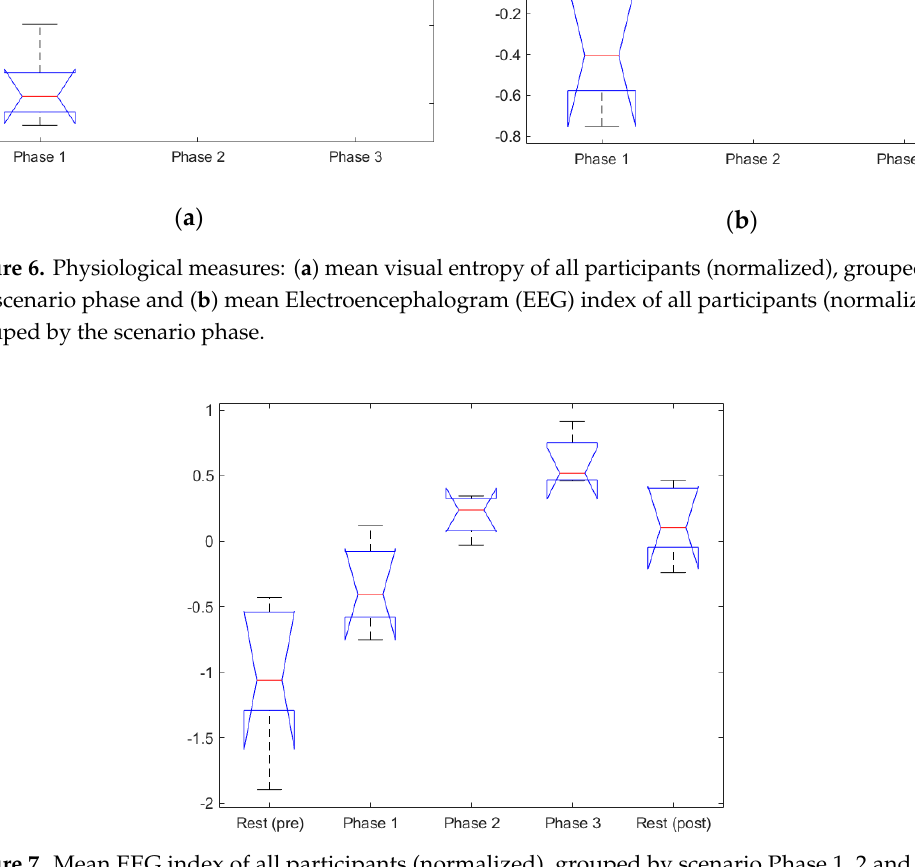
Figure 7. Mean EEG index of all participants (normalized), grouped by scenario Phase 1, 2 and 3 as well as Pre- and Post-resting.